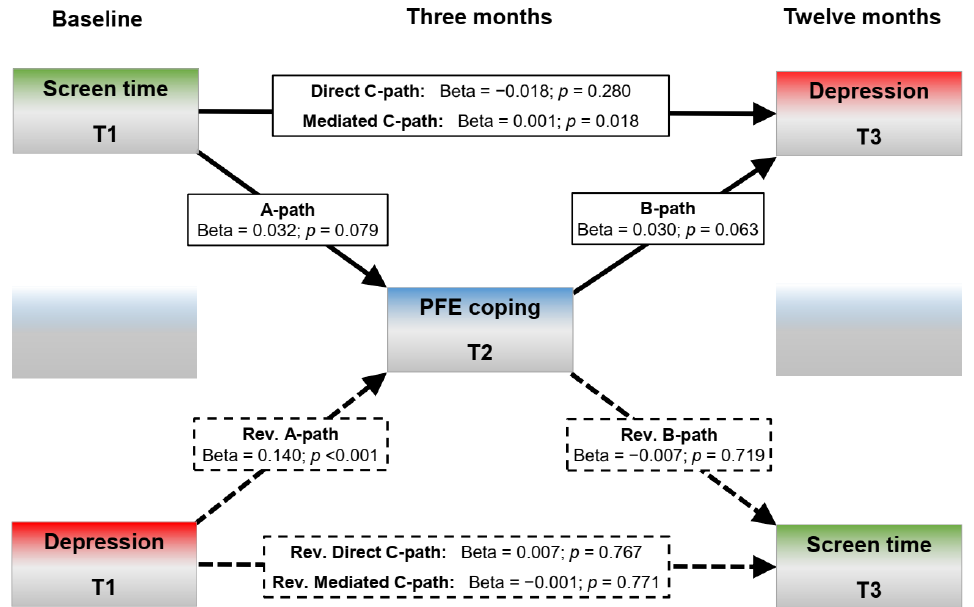
Figure 3. Structural regression (pathway) analysis and mediation test, with problem-focused engagement coping (PFE) as intermediate variable (50,000 bootstraps). Coefficients are standardized beta weights.